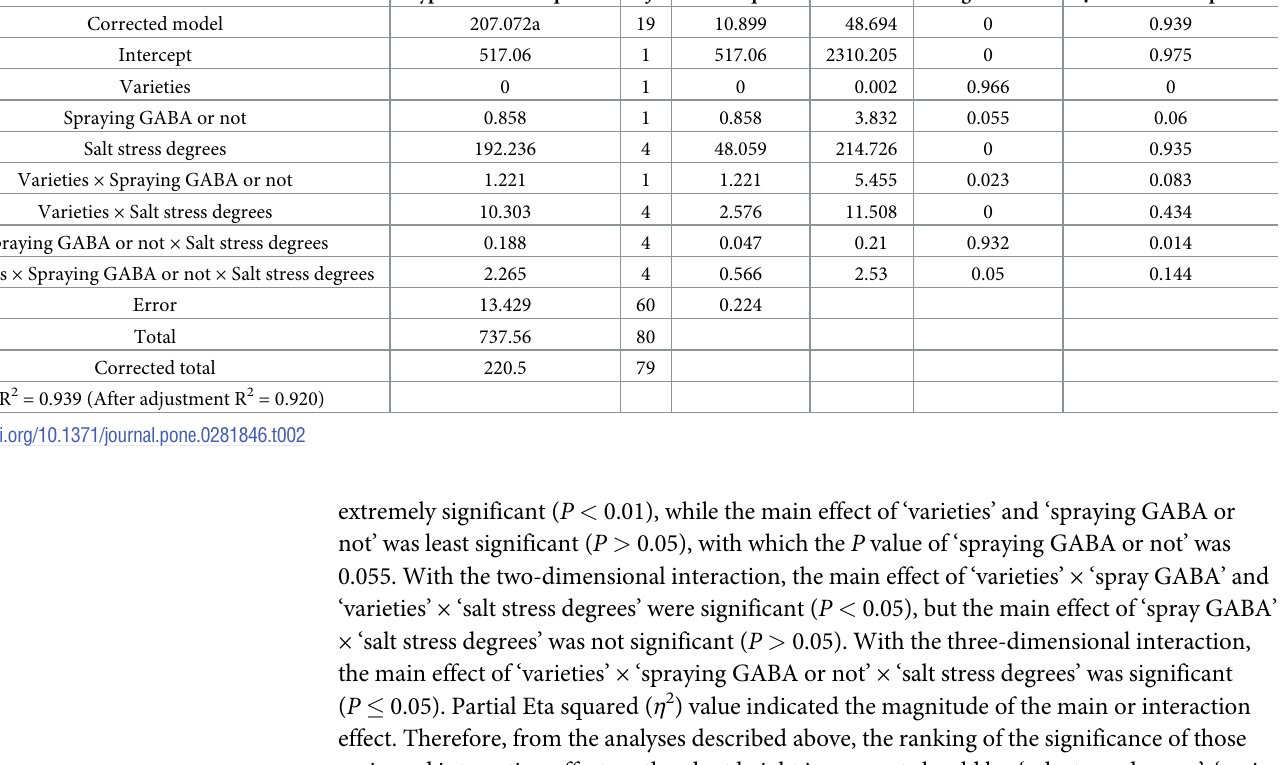
Table 3 indicated that the main effect of all three factors (‘varieties’, ‘spraying GABA or not’ and different ‘salt stress degrees’) significantly ( P < 0.01) affected the root dry weight, while two-dimensional interactions, such as ‘varieties’ × ’spray GABA’, ‘varieties’ × ‘salt stress degrees’ and ‘spraying GABA or not’ × ‘salt stress degrees’ were significant ( P < 0.05). With